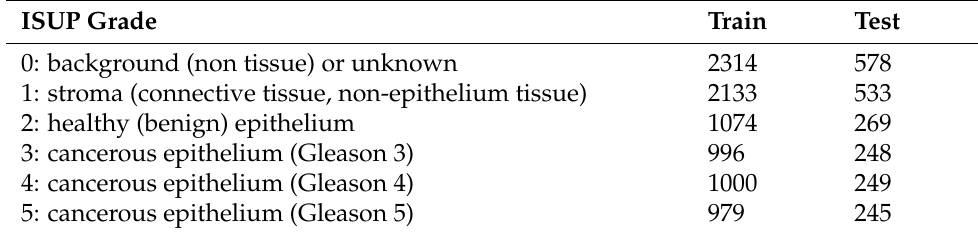
Table 1. The statistical information of the PANDA dataset. ISUP